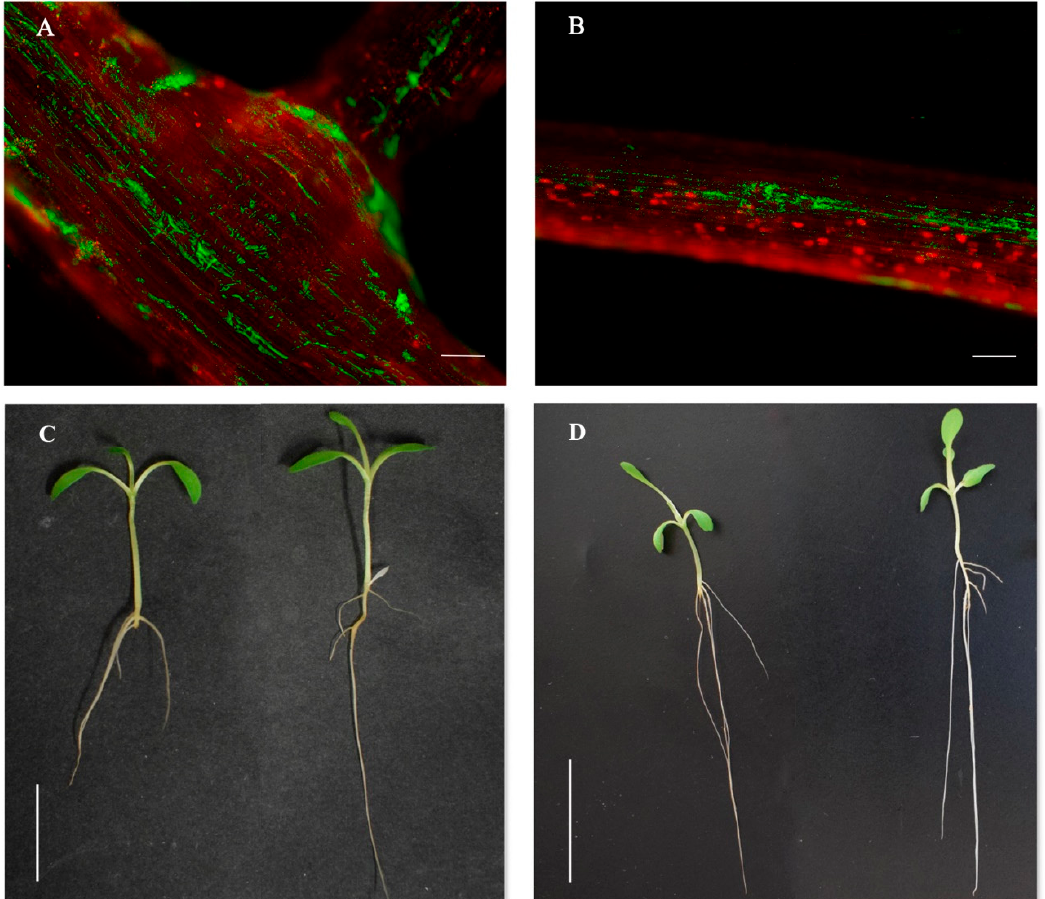
Figure 1. At the top, fluorescence optical micrographs of lettuce seedlings roots inoculated with HUTR05 green fluorescent protein (GFP)-tagged strains contrast stained with propidium iodide, seven days post inoculation: ( A ) show the ability of HUTR05 to colonize lateral root primordia (bar 250 µ m); ( B ) show the biofilms formation of HUTR05 (bar 320 µ m). At the bottom, general appearance of the seedlings ( C ) 7 dpi and ( D ) 14 dpi. Uninoculated control on the left and treated with HUTR05 on the right. Scale bars ( C ) 15 mm and ( D ) 30 mm.